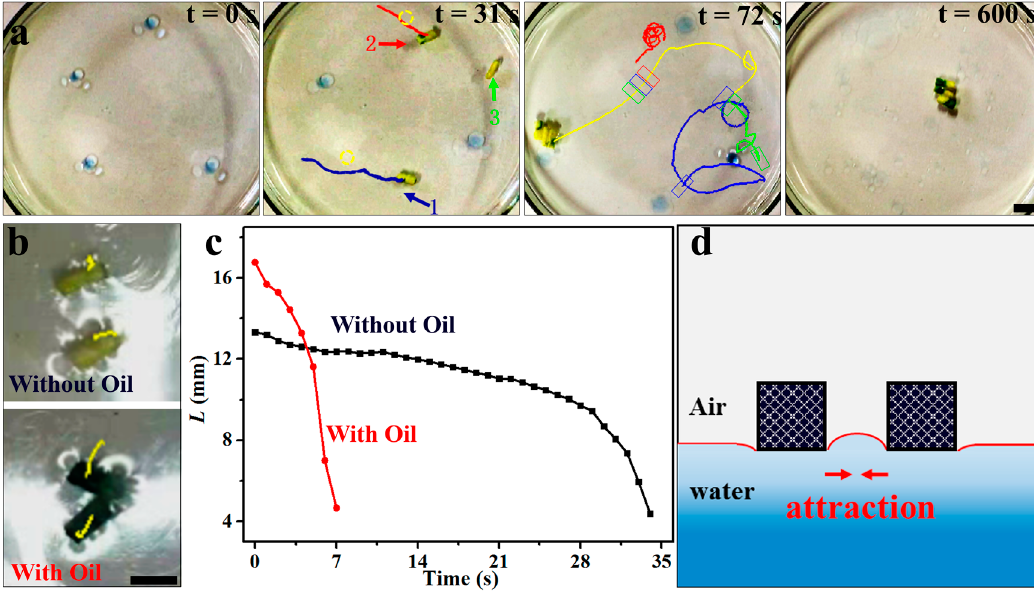
Figure 5. ( a ) Self-assembly of the Janus foam motors. ( b ) Trajectories of SA-PVA foams without oil and those with absorbed oil, reflecting a much faster self-assembly for the motors after oil absorption. ( c ) The distance (L) between the foams versus time. ( d ) Schematic demonstration of the self-assembly of the motors under capillary interactions. Scale bars: 10 mm.